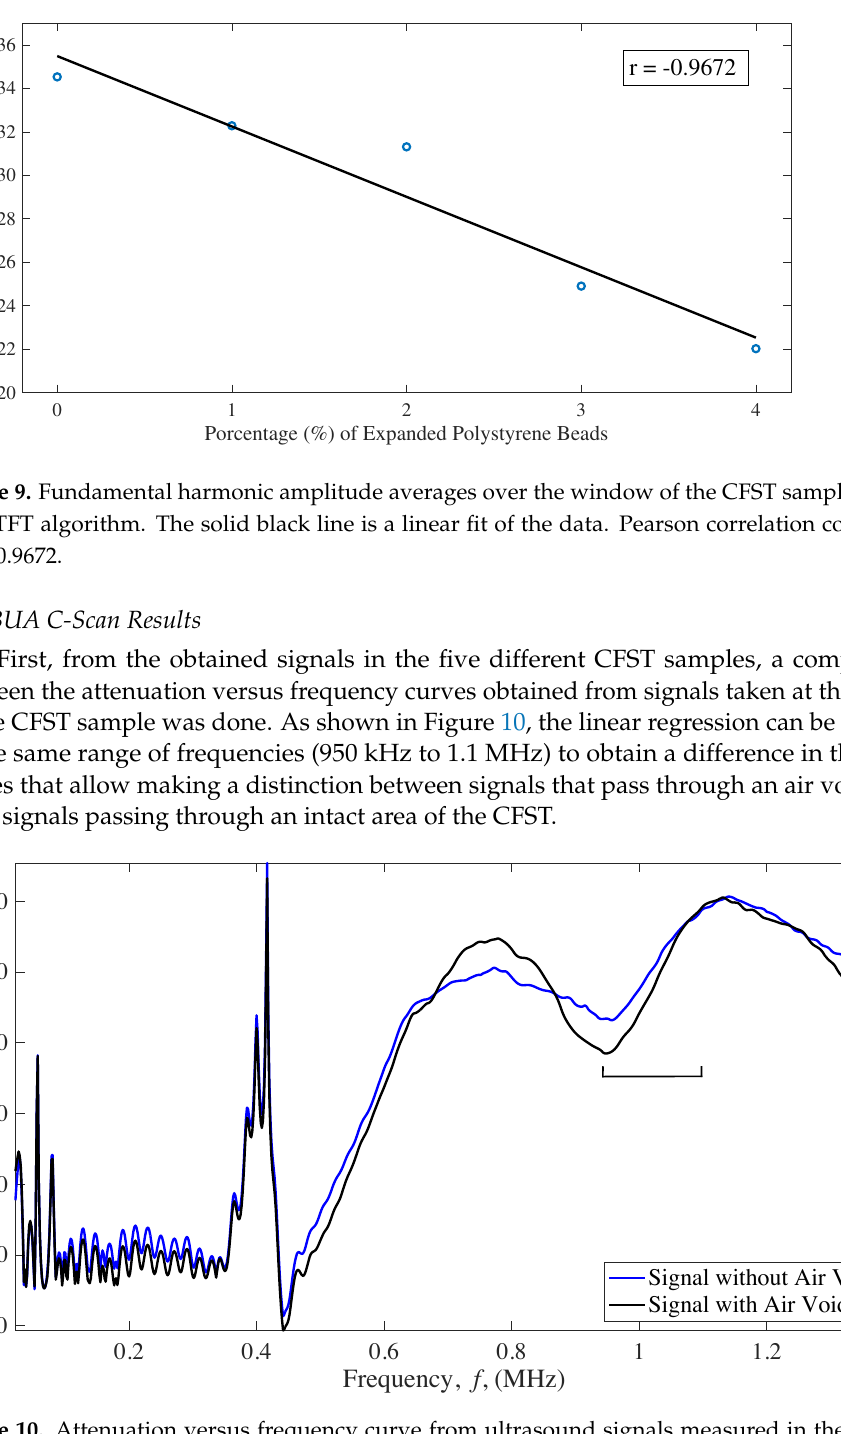
Figure 10. Attenuation versus frequency curve from ultrasound signals measured in the 5 CFST samples. The square bracket indicates the frequency range in which the linear regression is